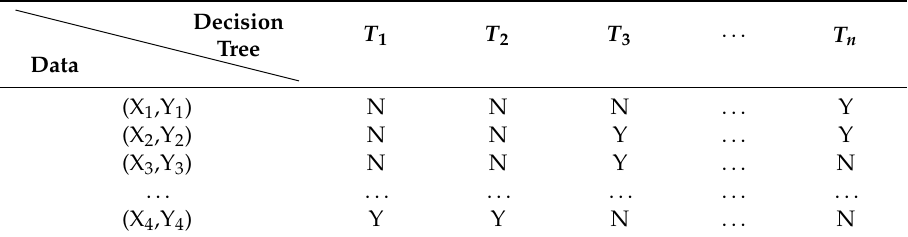
Table 1. The schematic of